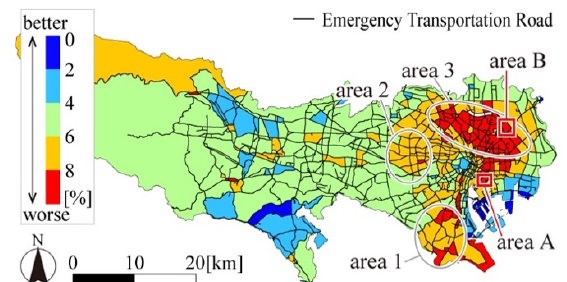
Figure 6. Spatial distribution of building collapse risk